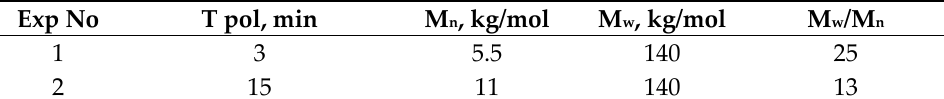
Figure 2. MWD curves of PE samples obtained from different polymerization durations: curve 1 — 3 MWD curves of PE samples obtained from different polymerization durations: min, curve 2 — 15 min. curve 1—3 min, curve 2—15 min.